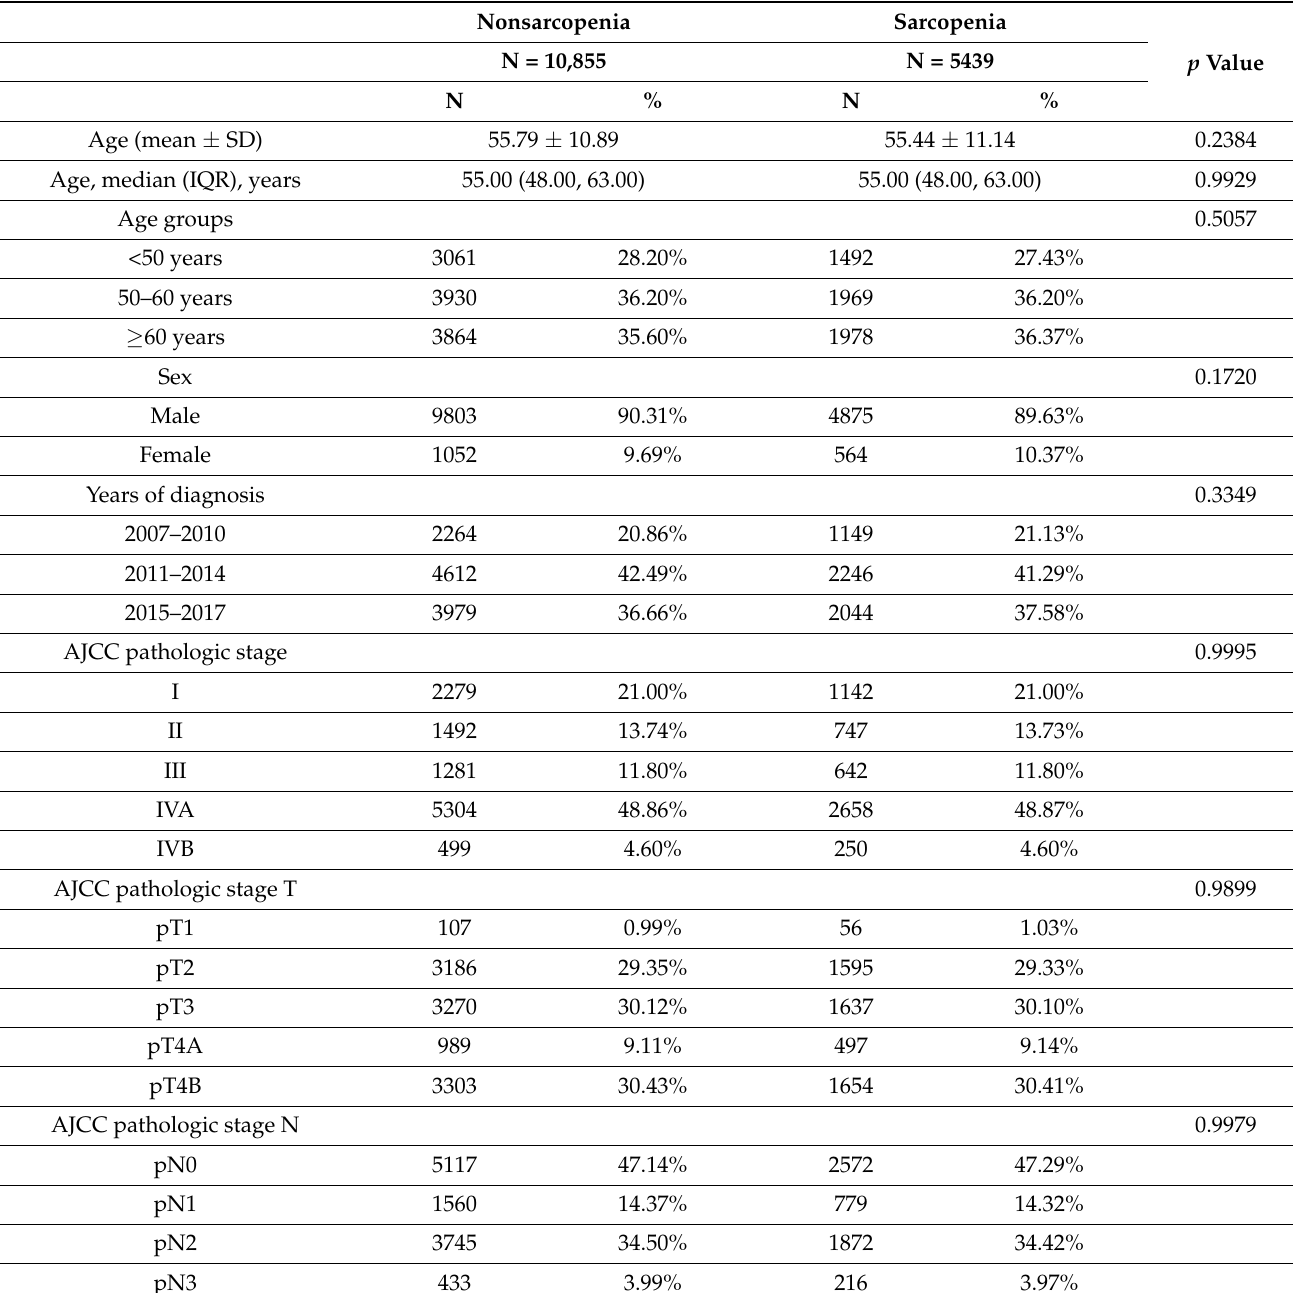
Table 1. Characteristics of patients with oral cavity squamous cell carcinoma with and without pre-existing sarcopenia (After propensity score matching